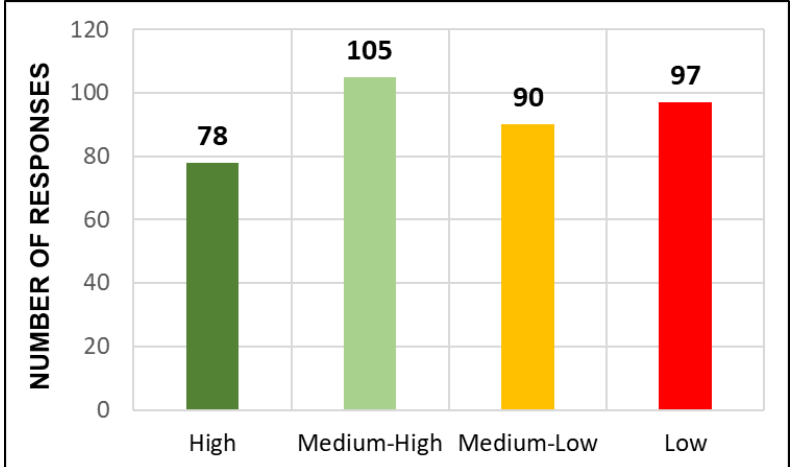
Figure 4. Energy- Use Behavior of Hotel Guests’ Motivation Level . Figure 4. Energy-Use Behavior of Hotel Guests’ Motivation